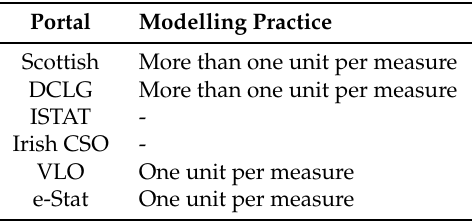
Table 24. Modelling practices of data portals for selecting number of units per measure. Portal Modelling Practice Scottish More than one unit per measure DCLG More than one unit per measure ISTAT - Irish CSO - VLO One unit per measure e-Stat One unit per measure